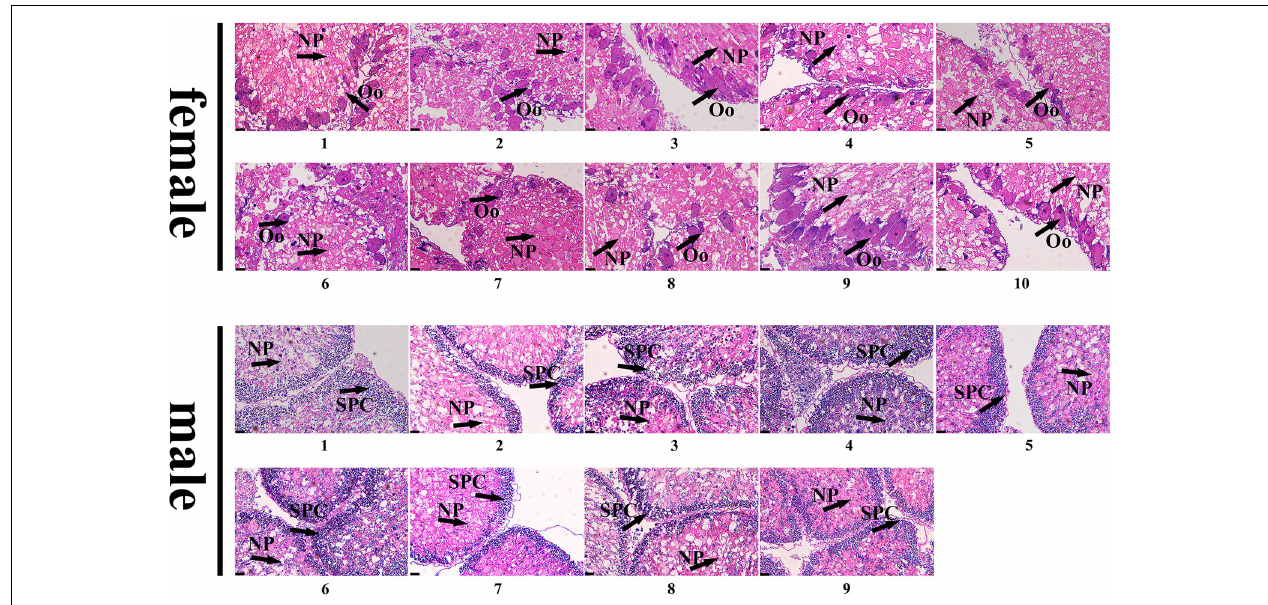
FIGURE 5 | Identification of 10 females and 9 males by histological detection of gonads in the wild population. NP, nutritive phagocytes; Oo, oogonia; SPC, spermatocyte.